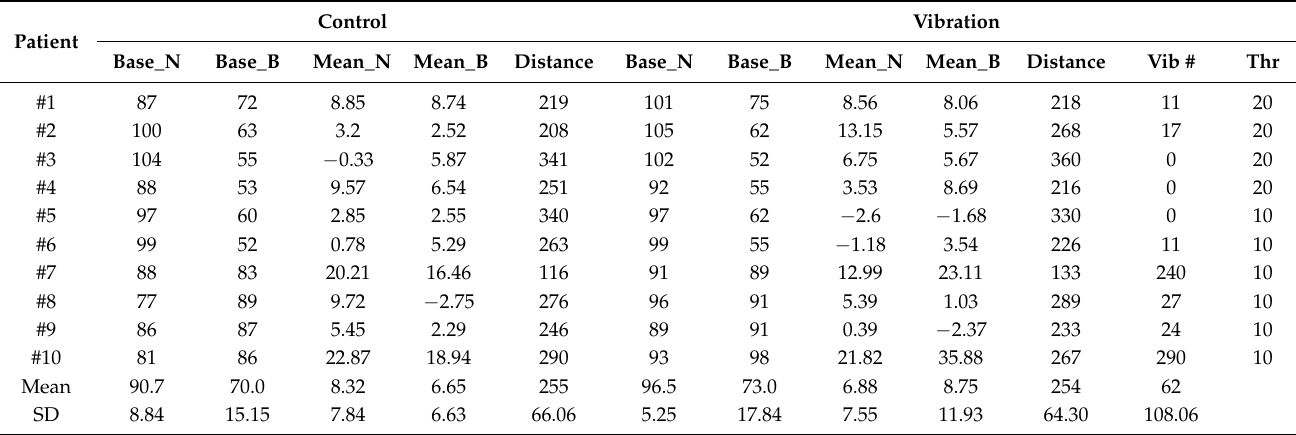
Table 2. Individual data of study